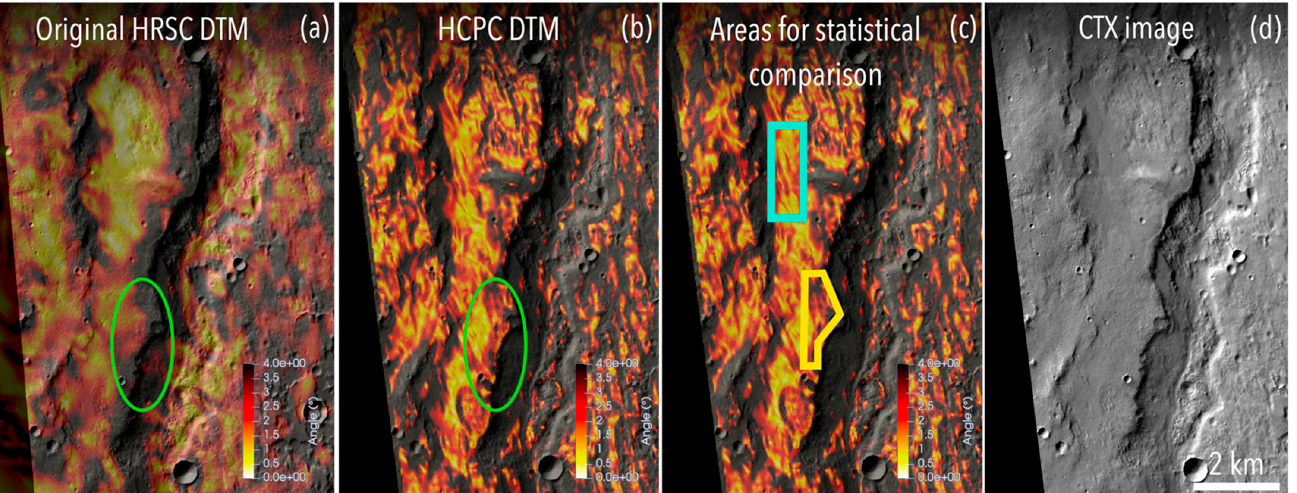
Table 3. Comparison of the mean and variance of the incidence angles for MOLA and HCPC DTMs, along with the variance in range on the northern and southern plateaus (see Figure 14 for the de- tailed outlines of the area). Northern Plateau